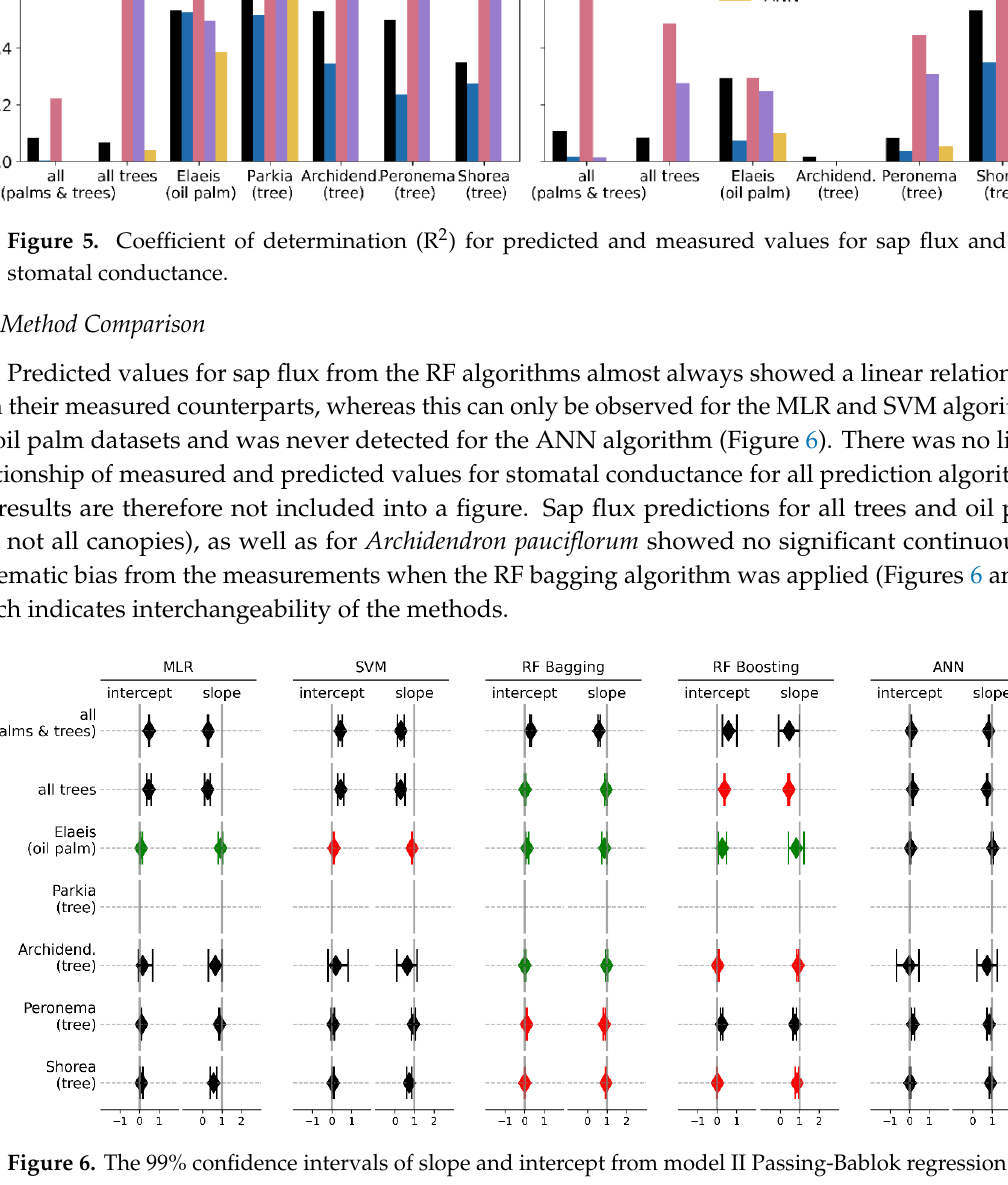
Figure 7. Measured and predicted sap flux for all tree and palm canopies from the RF bagging algorithm. The regression line of the Passing-Bablok regression is displayed in blue. The coefficient of determination is indicated by r² and the *** indicate a p-value well below 0.001. 3.3. Variable Importance A total of 96 input variables (or features) were available for our analysis. After applying a multicollinearity test and a backward elimination, the remaining 42 variables were used to train the prediction algorithms. To improve the distribution of measurement efforts and the relevance of input features, we performed a permutation importance analysis. Therein, the numbers of most important variables that explain 95% of the model outcome are highly variable (Figure 8). For the MLR, a very low number of only up to seven input variables (see Figure 9 for details) are required to explain most of the model prediction results for both sap flux and stomatal conductance. For the SVM algorithm, between 10 and 20 variables explain 95% of the model outcome; a smaller number of variables explain the sap flux results, while the number of variables was higher for stomatal conductance predictions. The RF algorithms showed the highest variations ranging from only one variable up to 20 for sap flux and generally using 15 to 20 main variables for stomatal conductance to explain most of the model’s